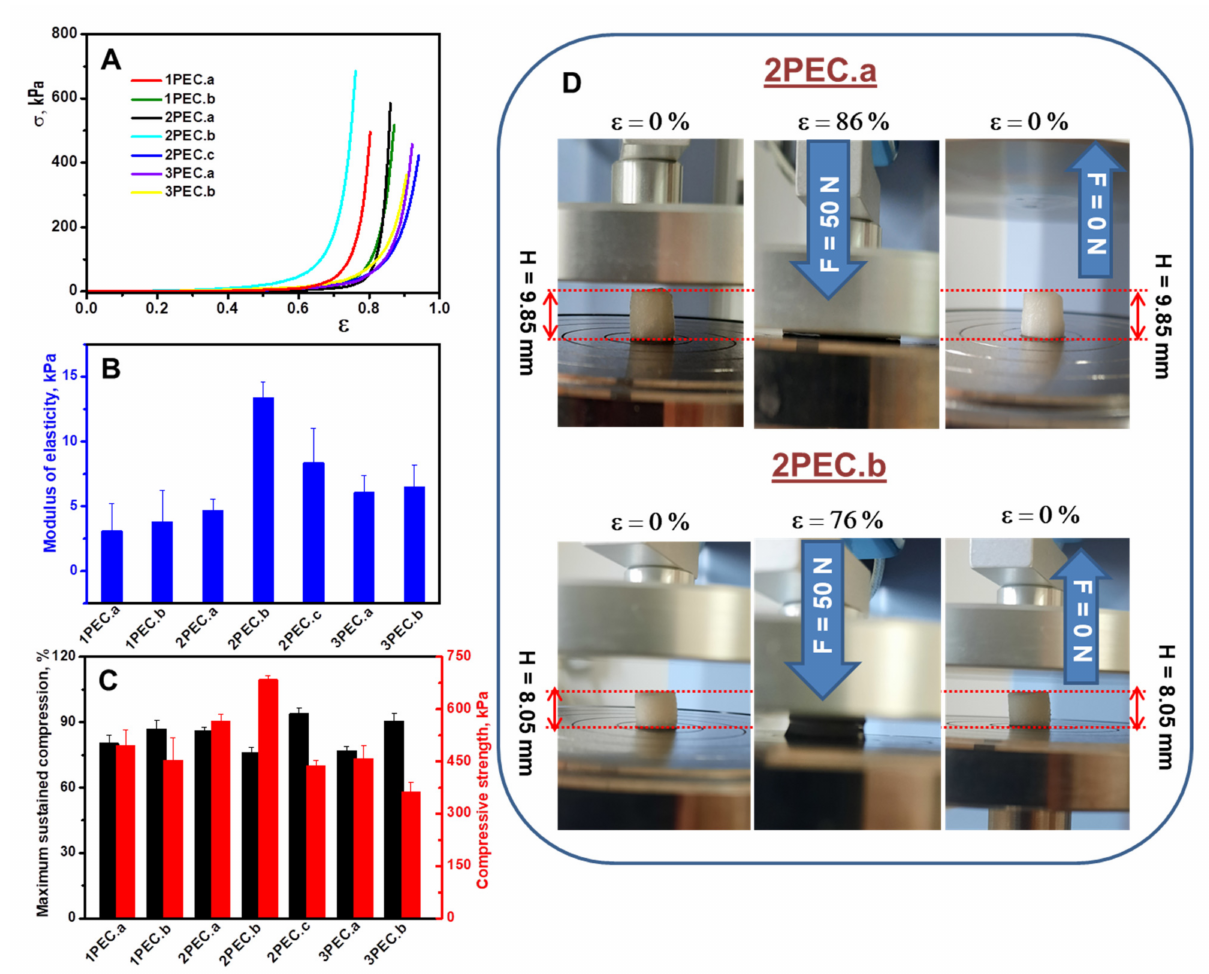
Figure 7. The mechanical properties of swollen PEC cryogels under compression: ( A ) stress-strain profiles of PEC cryogels; ( B ) Modulus of elasticity (blue color) determined according to the standard method; ( C ) Maximum sustained compression (black color) and compressive nominal stress (red color). Error bars represent standard deviation; ( D ) Optical images showing the compressibility, excellent elasticity, and instantaneous shape recovery of the 2PEC.a and 2PEC.b cryogels. The elastic modulus and the compressive nominal stress decreased to 6.08 kPa and, respectively, 458 kPa when PAMPS was used as polyanion (3PEC.a), being correlated